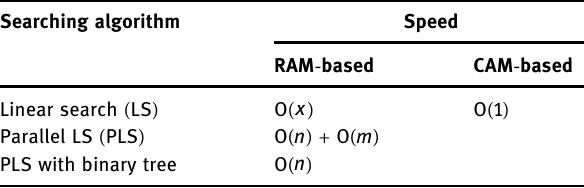
Table 4: Performance comparison for searching algorithms Searching